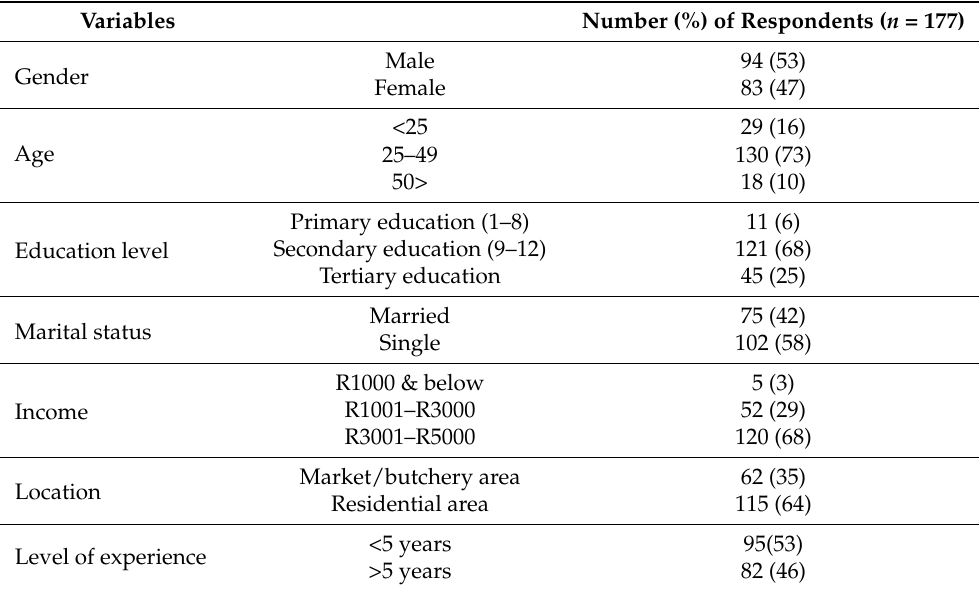
Table 2. Sociodemographic characteristics of workers at various butcheries in Vhembe district, Limpopo, South